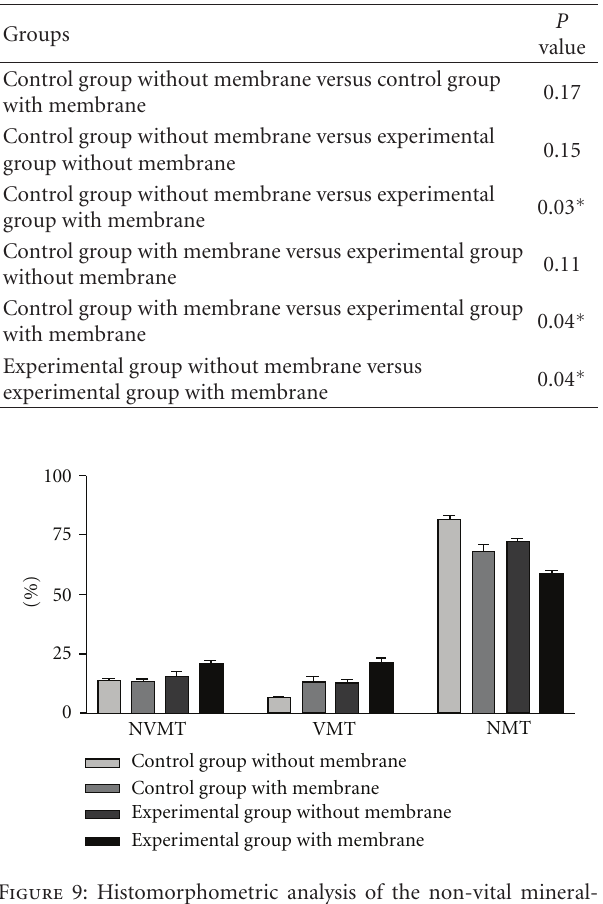
Figure 9: Histomorphometric analysis of the non-vital mineral- ized tissue (NVMT), vital mineralized tissue (VMT), and non- mineralized tissue (NMT) in percentage